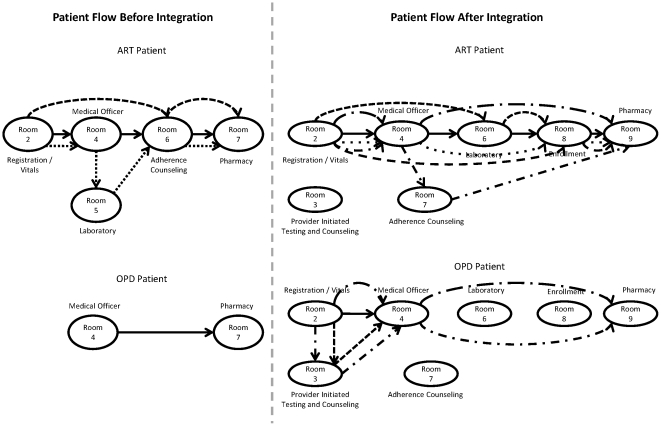
Typical patient flows before and after integration.Dotted lines represent different flow patterns through the clinics.